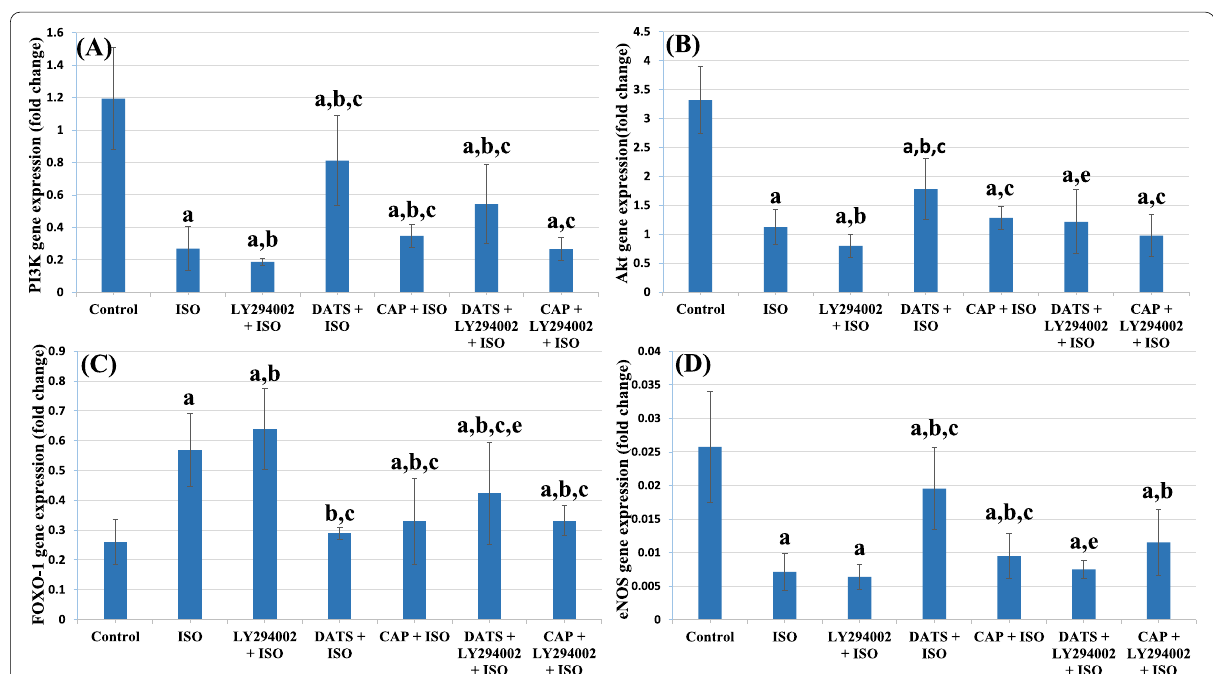
Fig. 3 Effect of treatment on the expression of cardiac PI3K/AKT downstream genes and apoptosis in the studied groups. A PI3K gene expression, B AKT gene expression, C FOXO‑1 gene expression, D eNOS gene expression. Data are presented as mean n 6. a: Significant versus normal control group. b: Significant versus ISO group. c: Significant versus LY294002 = DATS ISO group. PI3K: Phosphatidylinositide 3‑Kinases. Akt: Serine and Threonine Kinase. FOXO‑1: Forkhead Box Protein O‑1. eNOS: Endothelial + Nitric Oxide Synthase. ISO: Isoproterenol induced AMI group (85 mg/kg isoproterenol), LY294002 Diallyl trisulfide pretreated group (40 mg/kg), CAP ISO: Captopril pretreated group (50 mg/kg), DATS + inhibitor pretreated group, CAP LY294002 ISO: Captopril and PI3K inhibitor pretreated + +